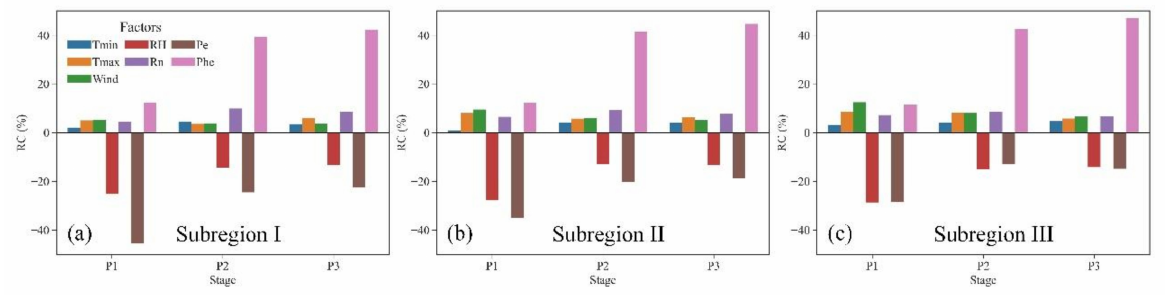
Figure 7. Average relative contribution of each factor to the irrigation water demand in P1, P2 and P3 stages of winter wheat in subregions I ( a ), II ( b ) and III ( c